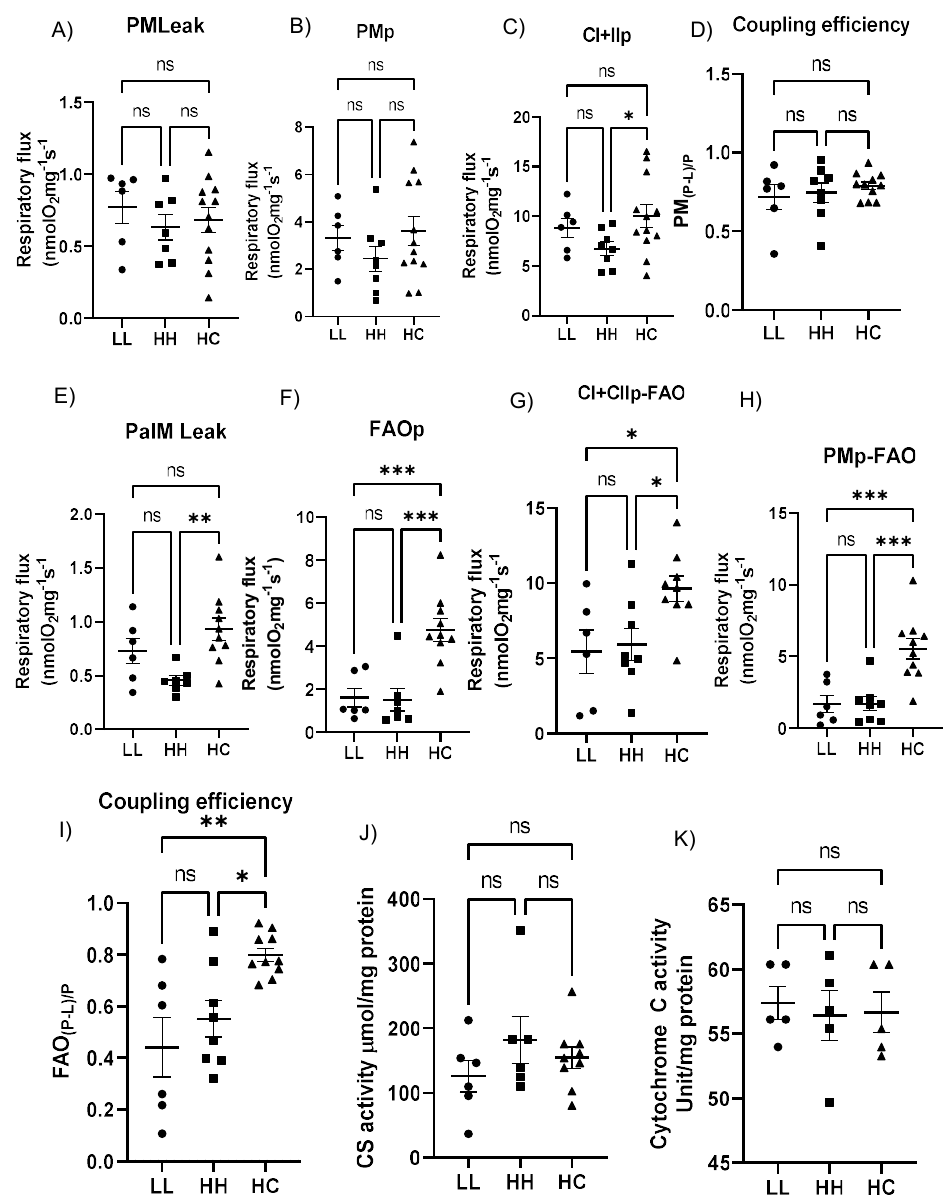
Figure 4G), and maximal OXPHOS-linked respiration rate (CI + CIIp FAO, Figure 4H) were all significantly higher in HC compared with HH. OXPHOS coupling control factors in the presence of fatty acids (FAO(P-L)/P, Figure 4I) were also significantly higher in HC compared to HH. Interestingly, no differences were found between LL and HH in all parameters of mitochondrial respiratory function. Citrate synthase (CS) activity, a common biomarker for mitochondrial density [13] (Figure 4J), and cytochrome c oxidase activity surface density [14], were similar among groups. Thus, the improved respiratory function (Figure 4K), a marker of mitochondrial cristae surface density [14], were similar among with fatty acid substrates shown in HC was not due to increased mitochondrial density groups. Thus, the improved respiratory function with fatty acid substrates shown in HC or mitochondrial cristae surface area. was not due to increased mitochondrial density or mitochondrial cristae surface area.